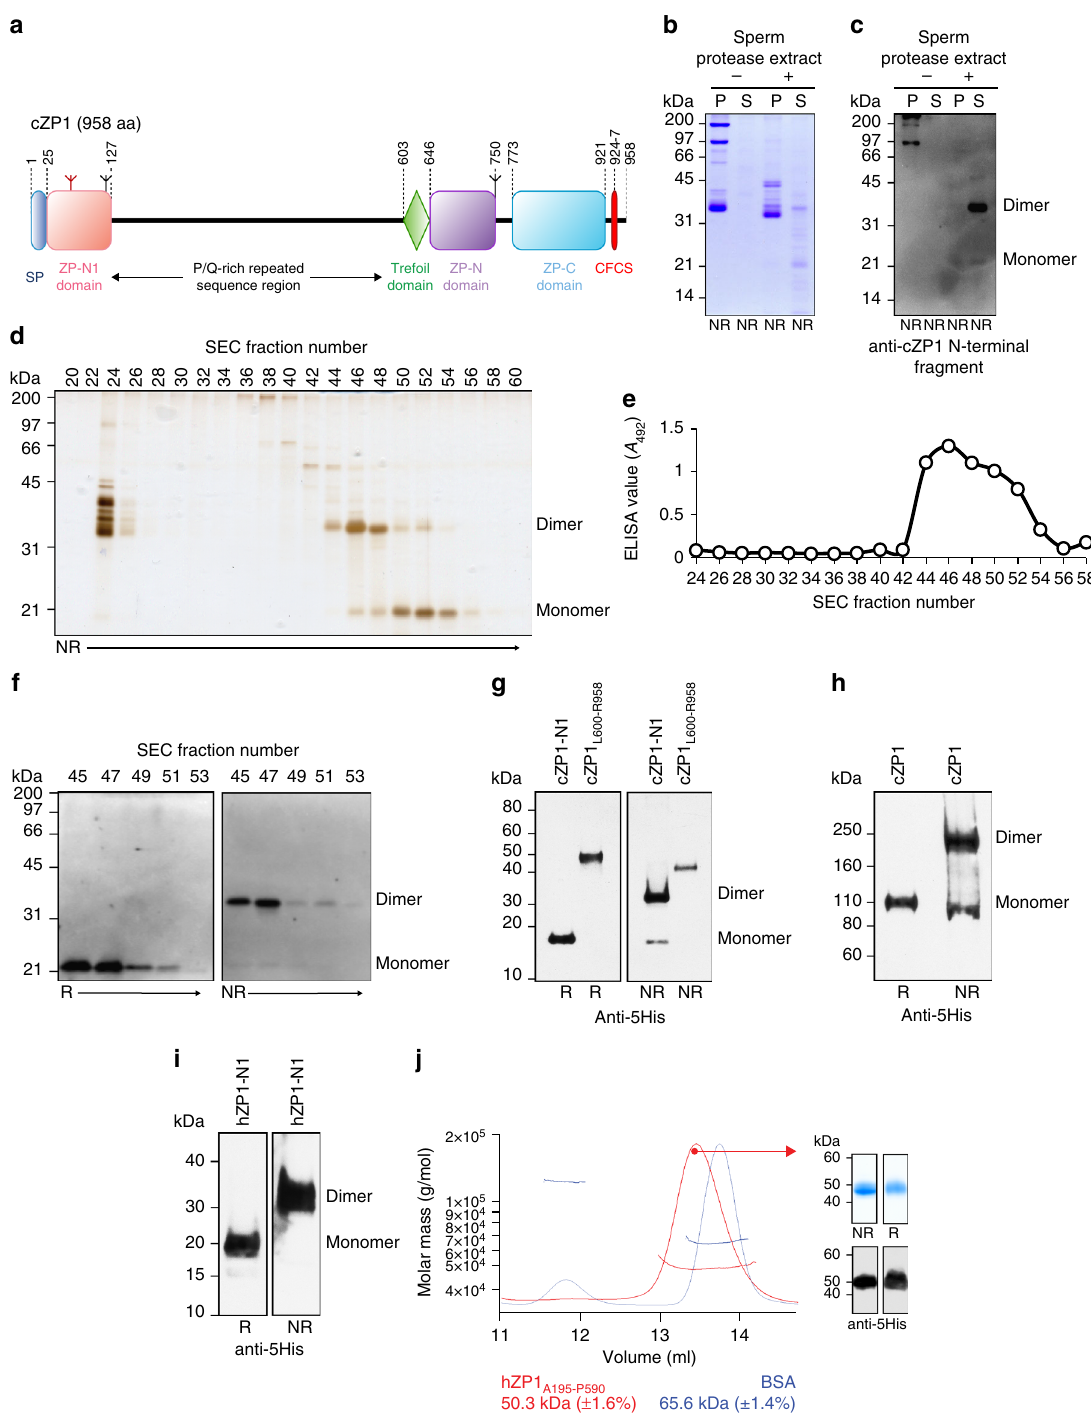
opposite subunit (Fig. 5c). Similarly, while H91(A) stacks against W72(B) in the deglycosylated cross-link structure (Fig. 5d), H91 faces I68 in both of the glycosylated cross-links (Fig. 5c). Additional contacts between residues in the ab loop/ β -strand B region and amino acids in the cd loop stabilises the asymmetric structure of the deglycosylated cZP1-N1 cross-link; in particular, invariant Q38(B) stacks against highly conserved F57(A) and also makes water-mediated hydrogen bonds with the side chains of T59(A) and invariant D55(A) (Fig. 5e). In the case of glycosylated cZP1-N1, on the other hand, the relatively more extensive B/B ′ molecule interface is stabilised by a long-range hydrogen bond